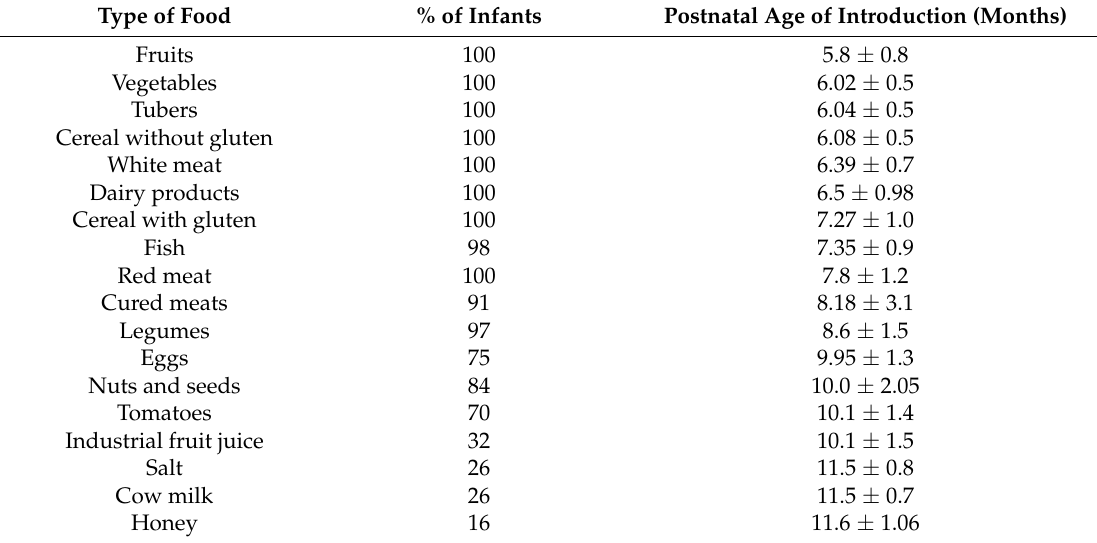
Table 5. Percentage of infants that have been introduced different types of complementary foods by the completion of 12 months of age and mean postnatal age (months) of food type